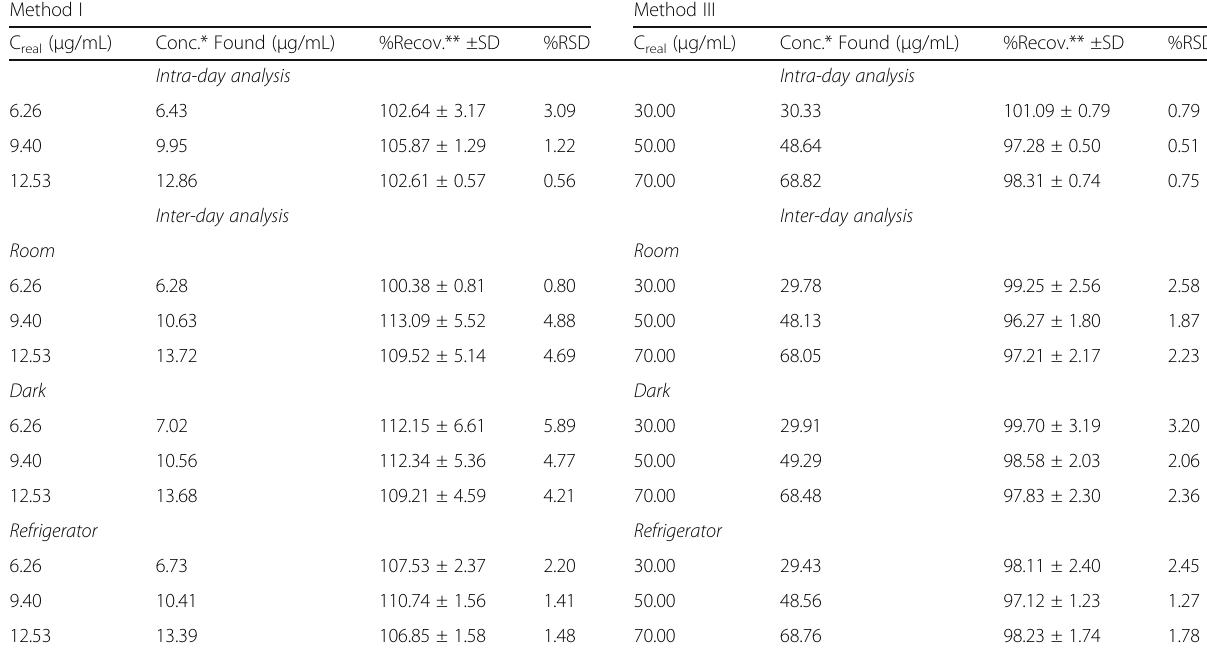
Table 5 Precision data of tenofovir by proposed methods Method I Method III C real ( μ